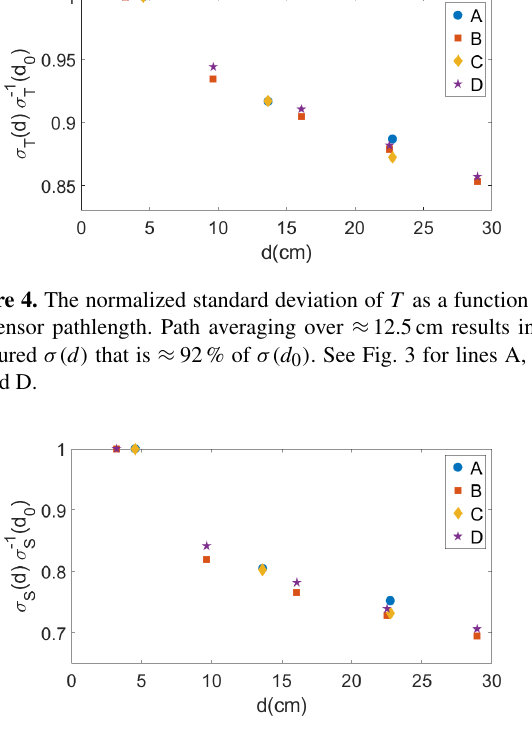
Figure 5. The pathlength-averaged σ S (d) normalized by σ S (d 0 ) (the value measured in a single bin). Path averaging over ≈ 12.5cm decreases σ S to ≈ 81% σ S (d 0 ) . See Fig. 3 for lines A, B, C, and